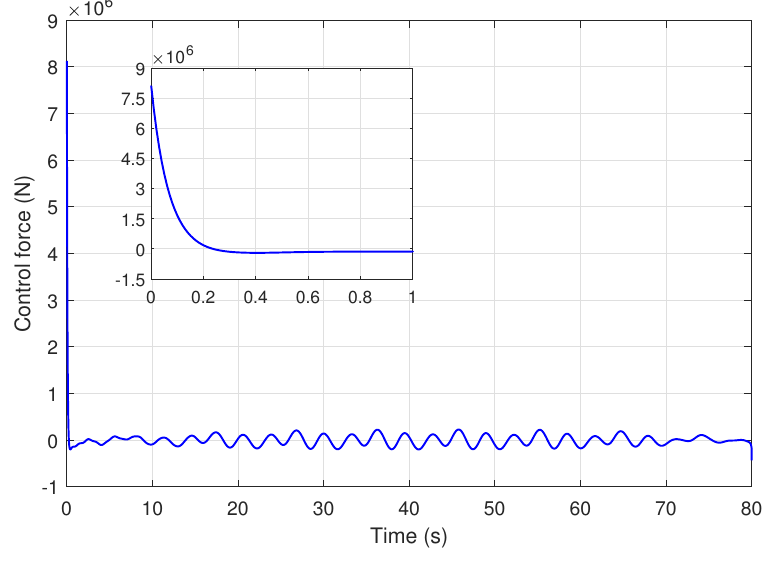
Figure 12. Control force by